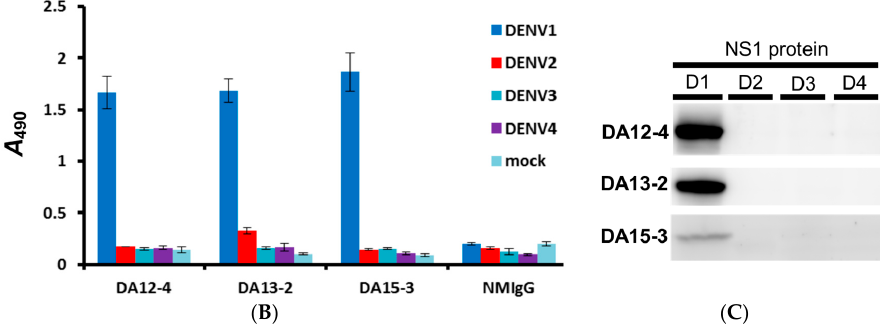
Figure 1. Identification of mAbs against NS1 protein by immunofluorescence assay, cellular ELISA, and Western blot analysis. ( A ) The indicated mAbs (DA12-4, DA13-2, and DA15-3) were individually incubated with BHK21 cells infected with DENV1 virus (strain Hawaii), DENV2 virus (strain 16681), DENV3 virus (strain H87) and DENV4 virus (strain H241). Magnification 400×. After secondary antibody and DAPI staining, the signals were detected by immunofluorescence microscopy; ( B ) C6/36 cells infected with the indicated serotype were incubated with the indicated mAbs for further analysis by cellular ELISA; ( C ) Lysates from C6/36 cells infected with the indicated serotypes of DENV were separated on a non-reducing gel, D1: DENV1-infected C6/36 cell lysate; D2: DENV2-infected C6/36 cell lysate; D3: DENV3-infected C6/36 cell lysate; D4: DENV4-infected C6/36 cell lysate. DENV1 NS1 protein was recognized by DA12-4, DA13-2, and DA15-3. Table 1. Characterization of DENV1 mAbs by IFA, ELISA, WB.